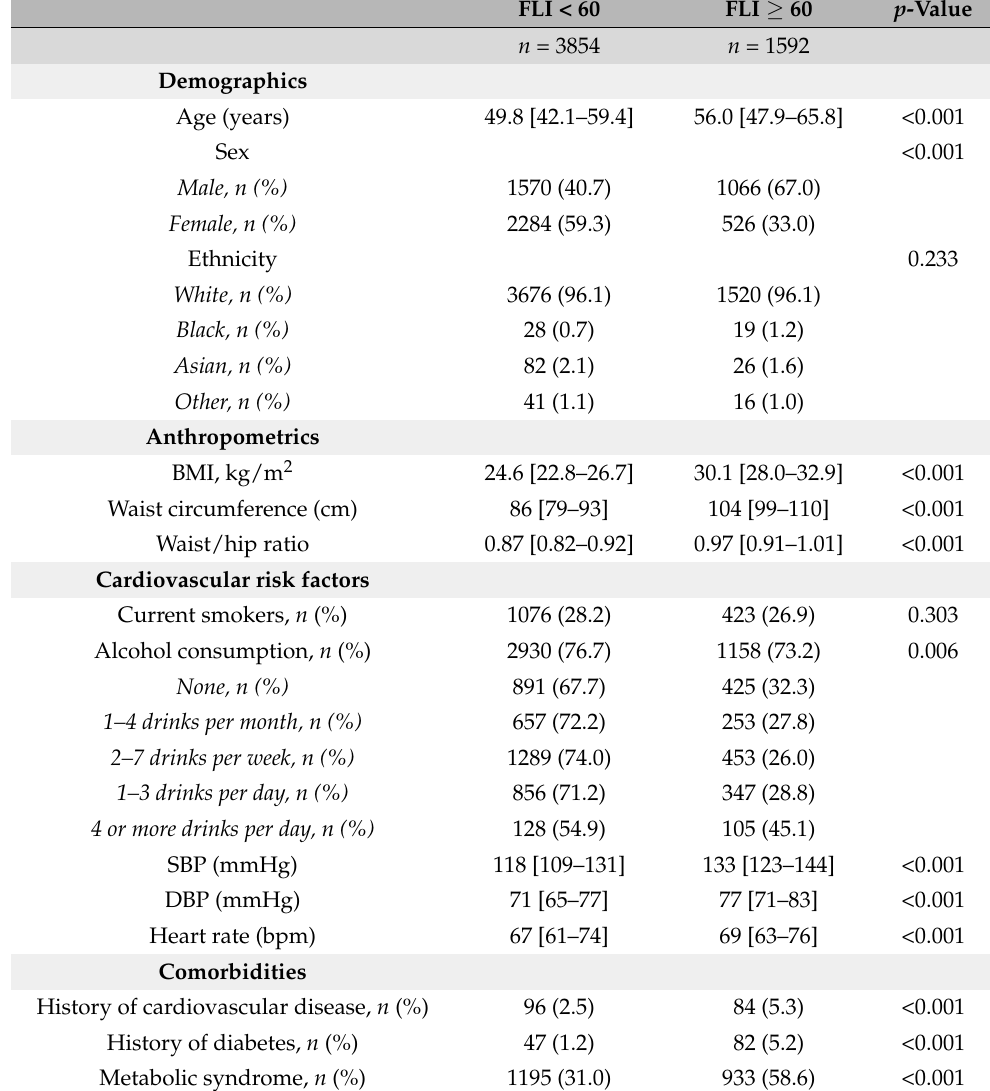
Table 1. Baseline demographic, clinical and laboratory characteristics compared between 3854 subjects with a fatty liver index (FLI)< 60 and 1592 subjects with a FLI ≥ 60. FLI < 60 FLI ≥